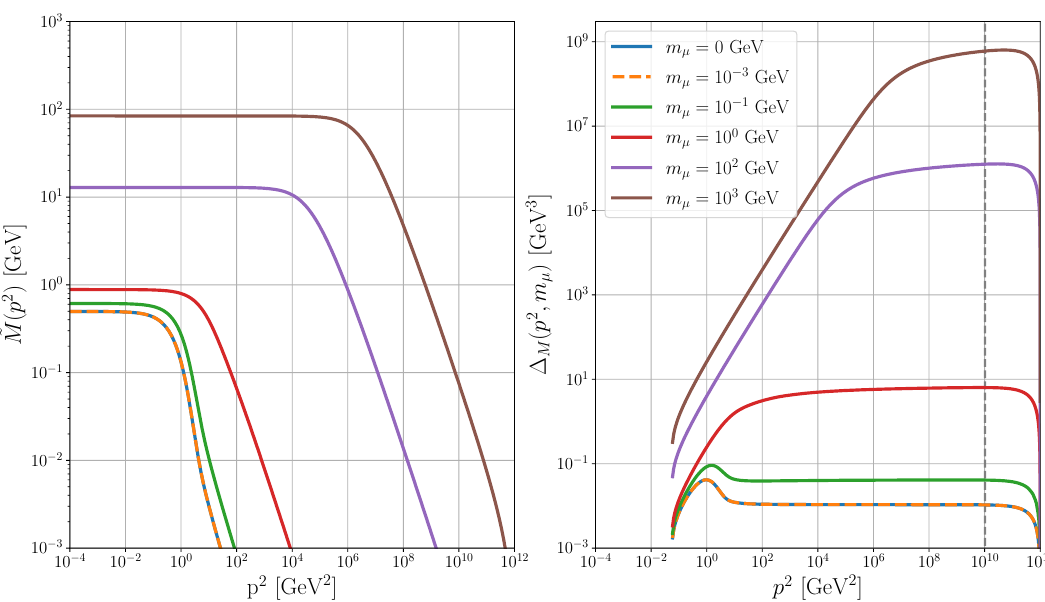
( p 2 , m ) (right) for fermions in a color triplet repre- Figure 2: ˜ M ( p 2 ) (left) and ∆ µ M sentation with different current masses. The dashed vertical line in the right plot indicates the momentum that we use to determine the value C ( m µ )